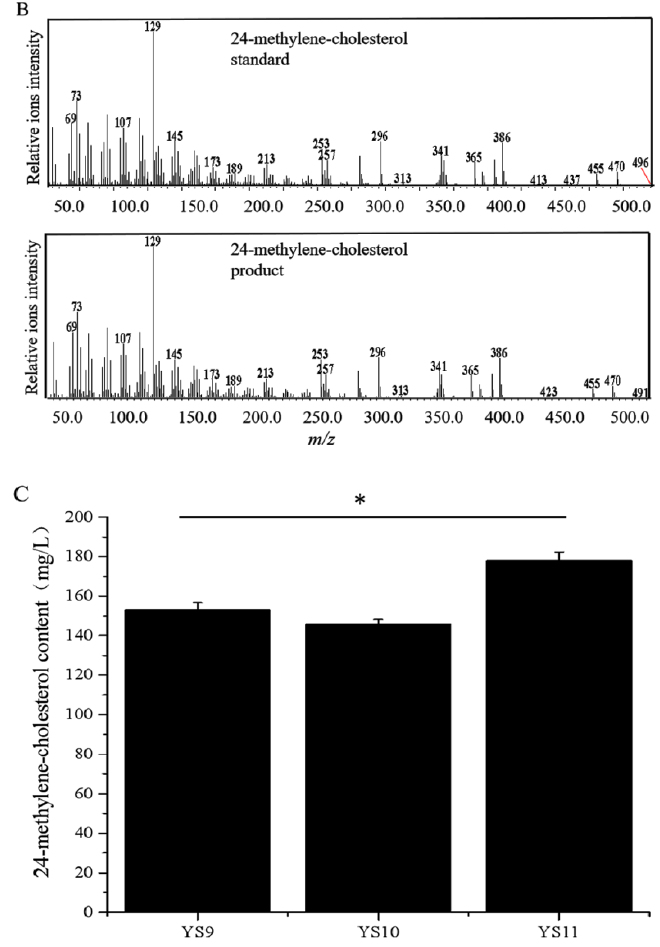
Figure 4. Identification of fermentation products in recombinant yeast strains via gas chromatography–mass spectrometry (GC–MS): ( A ) GC–MS patterns of the parent strain YS5 producing ergosterol, and YS9–11 strains producing the 24-methylene-cholesterol product. ( B ) Mass chromatography of the 24-methylene-cholesterol product as well as its authentic standard. ( C ) Quantification of the 24-methylene-cholesterol produced by the strains YS9, YS10, and YS11. Error bars represent standard deviations ( n = 3). Asterisks indicate significant differences compared to YS9 and YS10; Student’s t ‐ test, * p < 0.05.